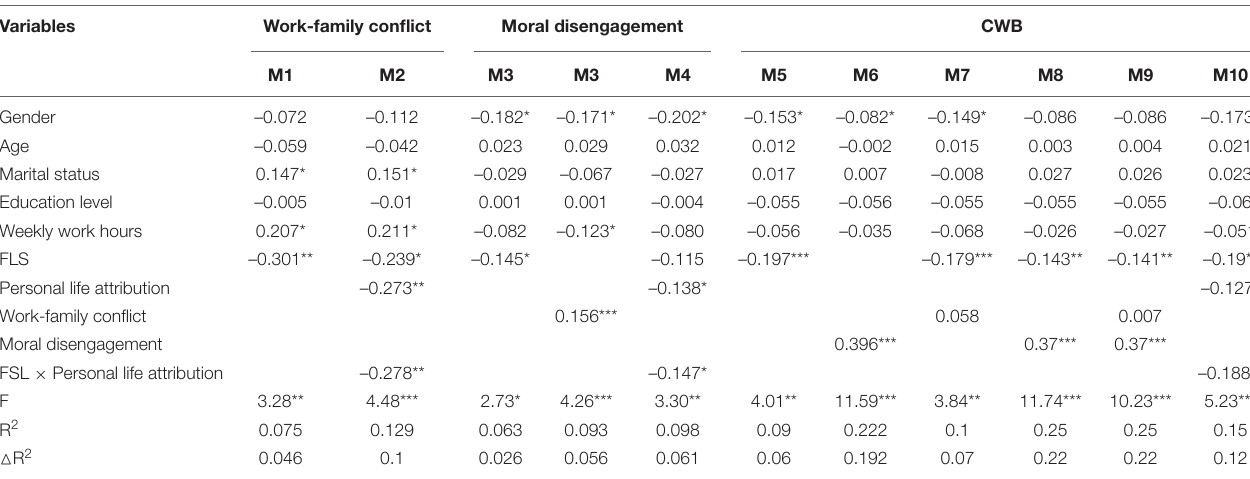
TABLE 3 | Results of hierarchical regression analysis.